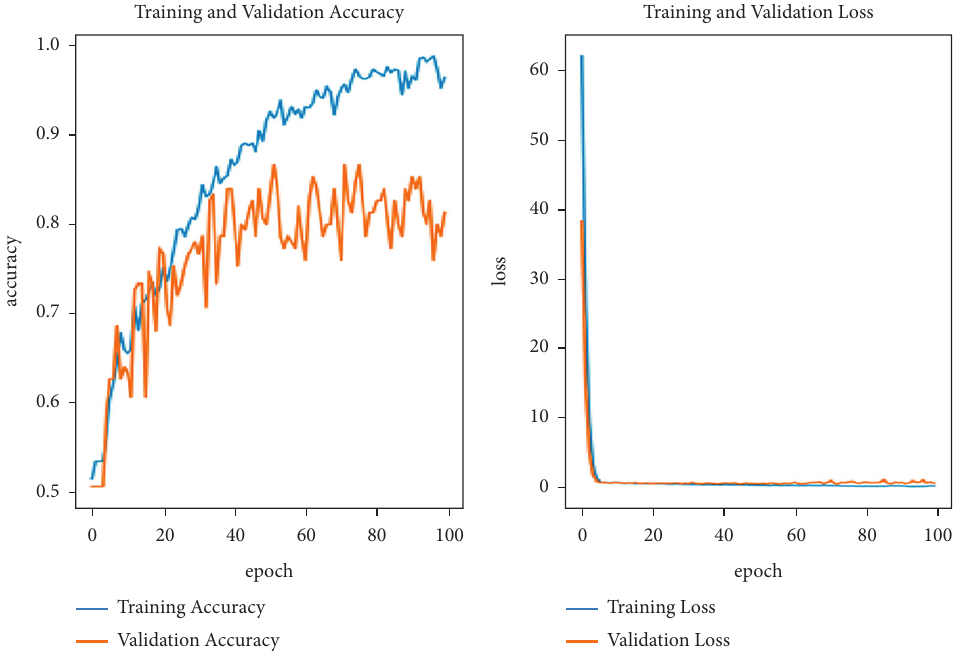
Figure 9: Accuracy and loss with Xception